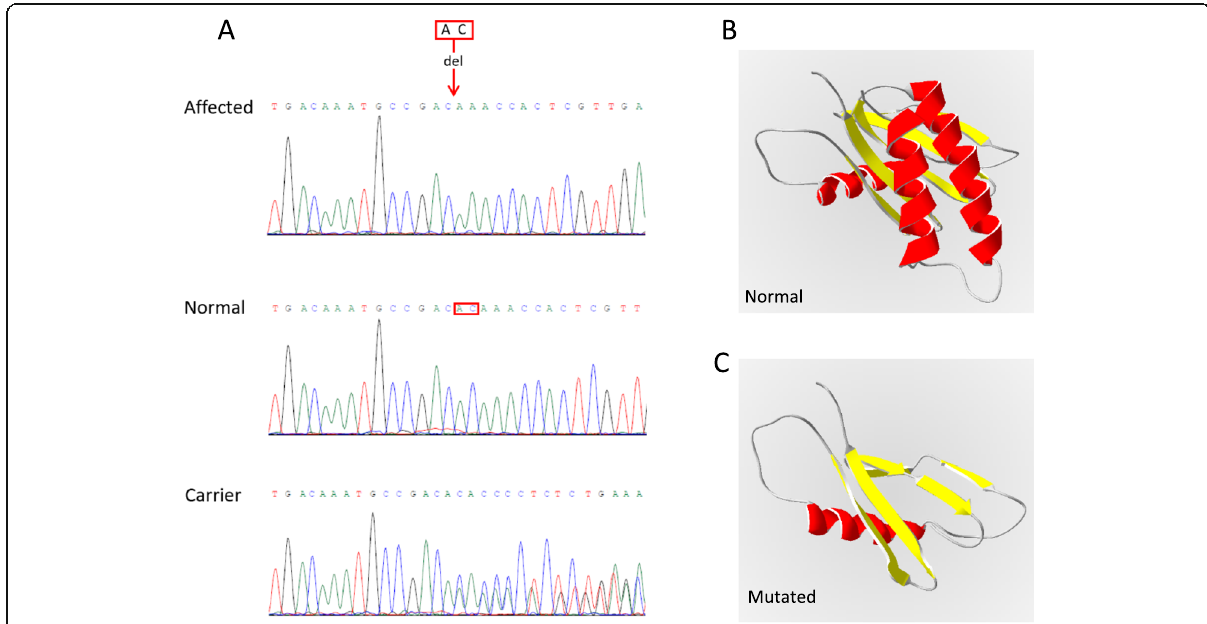
Fig. 3 Sequence analysis of the family and the predicted structure of the mutated protein. a , Sequencing chromatograms of affected members (V1, V2, IV3), unaffected members (IV1, III4, IV6, V4), and carriers (IV2, III5, IV5, V3) from this family. The red arrow indicates the locus of the c.216_217del variant, and the red box indicates the corresponding normal sequence. b , the predicted secondary structure of the normal TRAPPC2 protein. c , the predicted secondary structure of the mutated TRAPPC2 protein (p.